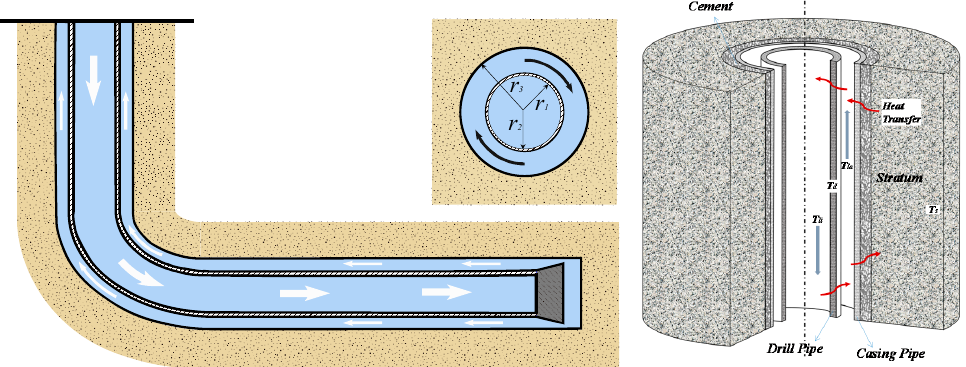
Figure 1. Sketch of wellbore geometry.